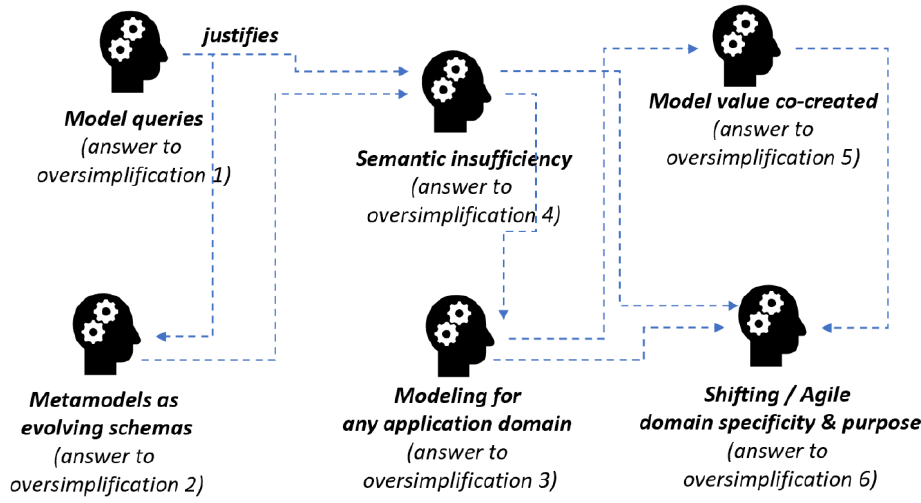
Figure 4. A workflow template for Conceptual Modeling